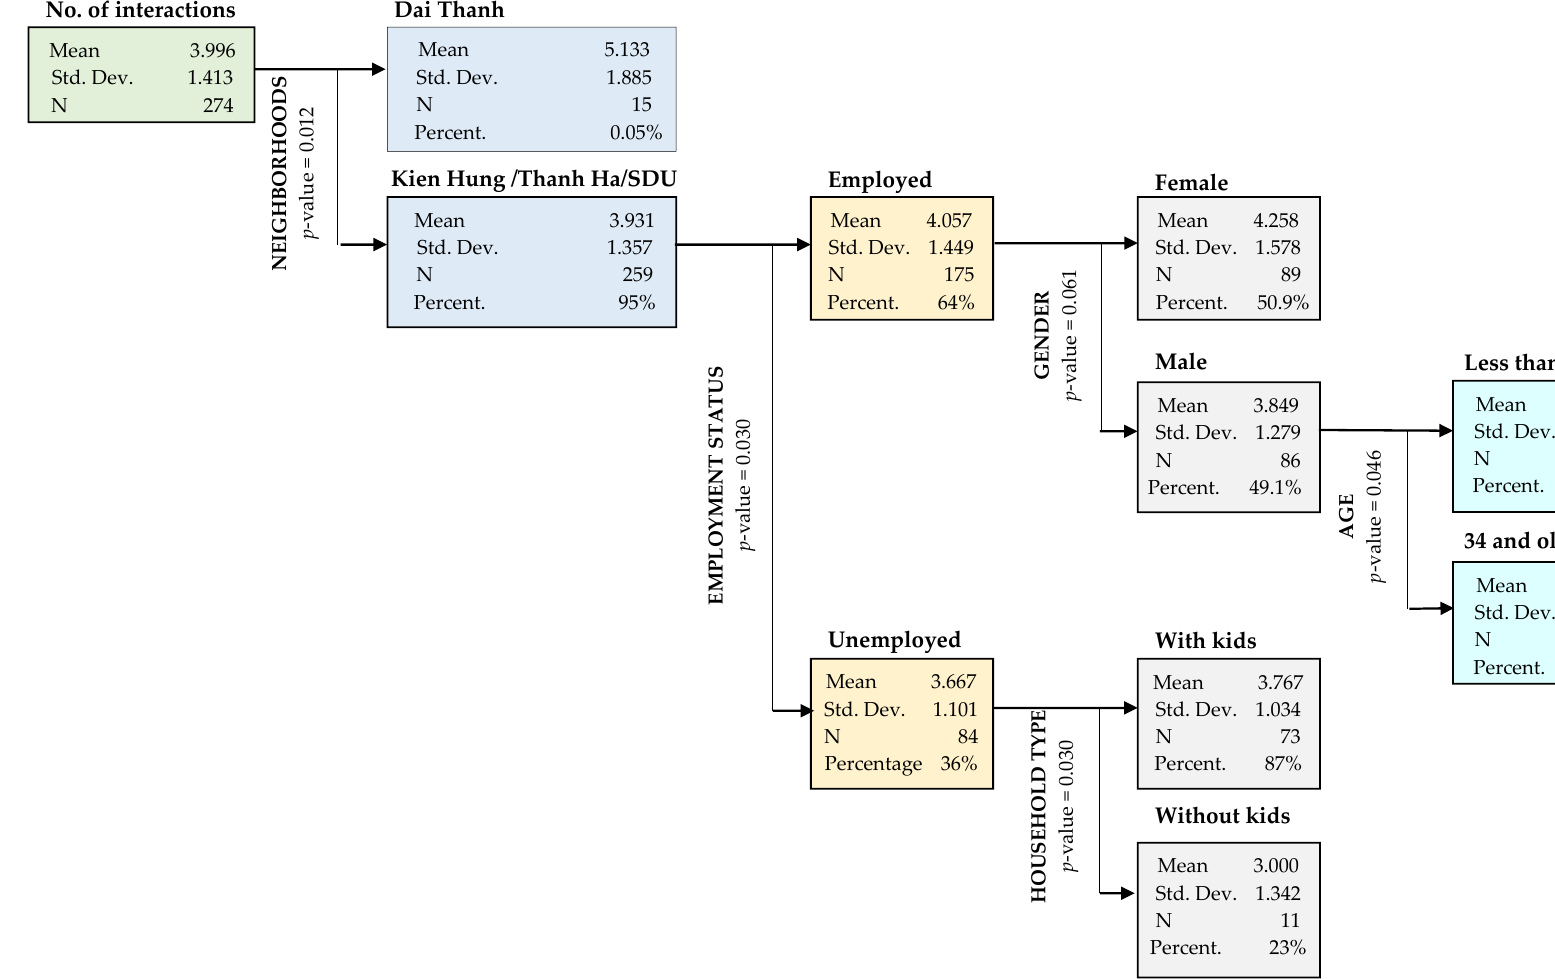
Figure 4. Clusters of residents based on number of social